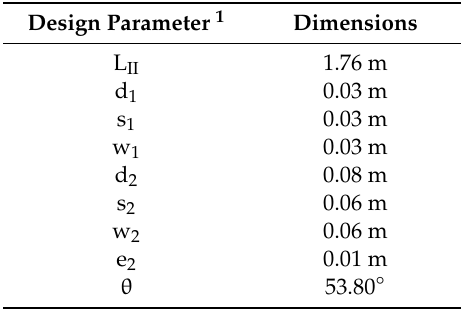
Table 1. Dimensions of the typified USBR II stilling basin physical model.